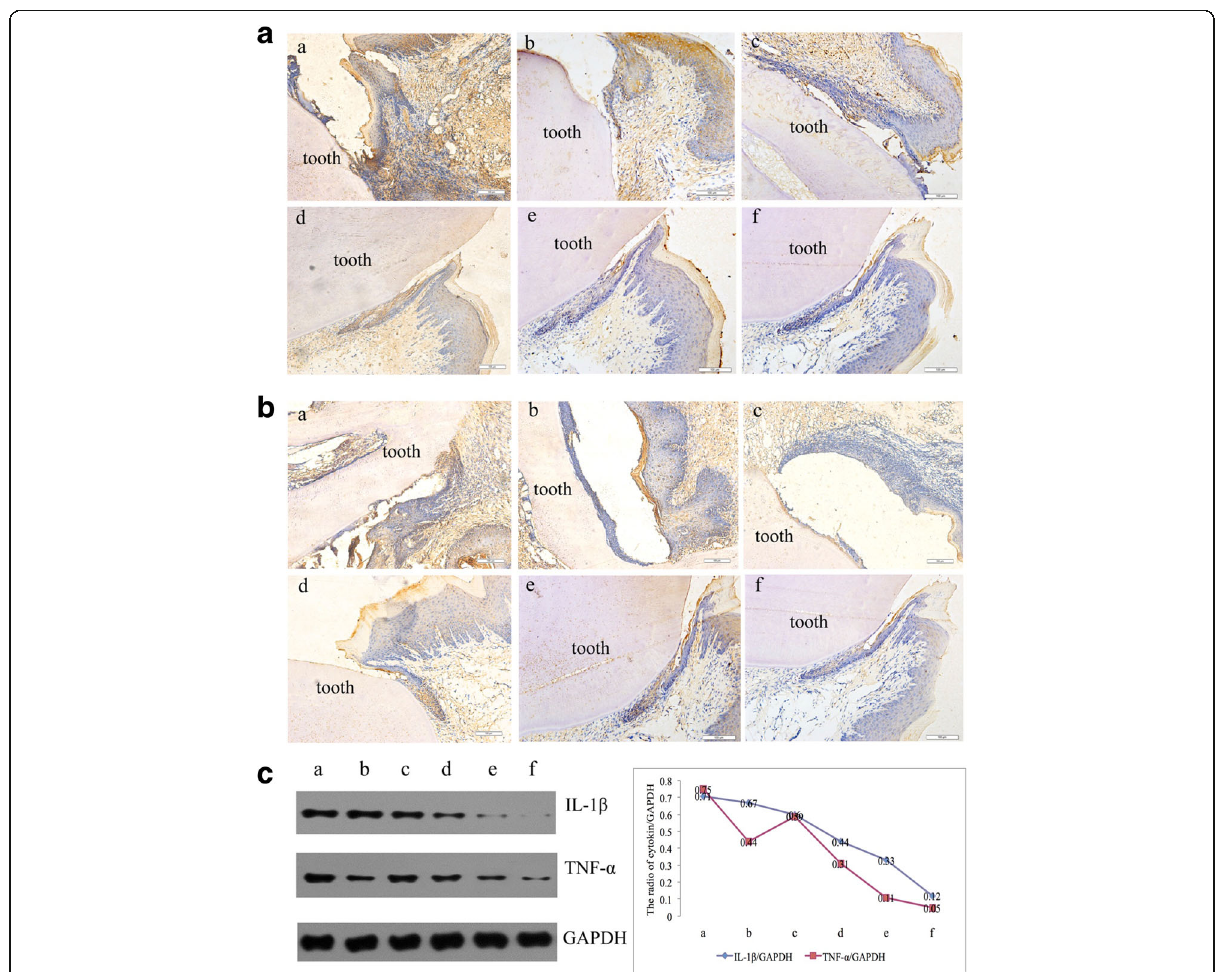
Fig. 3 Expression of IL-1 β and TNF- α in periodontal tissue. a IL-1 β expression in the periodontal tissue of rats detected by immunohistochemistry. Brown staining indicates positive immunoreactivity. b TNF- α expression in the periodontal tissue of rats detected by immunohistochemistry. Brown staining indicates positive immunoreactivity. c Levels of IL-1 β and TNF- α detected by western blot analysis. The mean values of IL-1 β and TNF- α were measured by densitometry using Gel-Pro32 software. a: P. gingivalis W83 alone; b: P. gingivalis W83 plus 6.25 μ g/mL of Nal-P-113; c: P. gingivalis W83 plus 25 μ g/mL of Nal-P-113; d: P. gingivalis W83 plus 100 μ g/mL of Nal-P-113; e: P. gingivalis W83 plus 400 μ g/mL of Nal-P-113; f: control group, without P. gingivalis or Nal-P-113. The data are presented as the means of 12 rats in each group. Magnification,